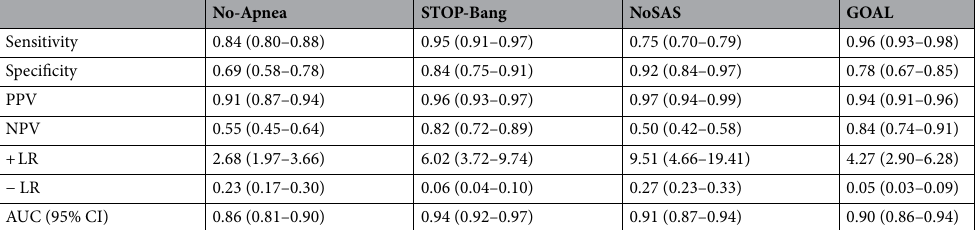
Table 2. Predictive parameters of the four screening tools at AHI ≥ 5 events/h. AHI apnea hypopnea index, PPV positive predictive value, NPV negative predictive value, + LR positive likelihood ratio, − LR negative likelihood ratio, AUC area under the curve. Data are presented as values (95% confidence